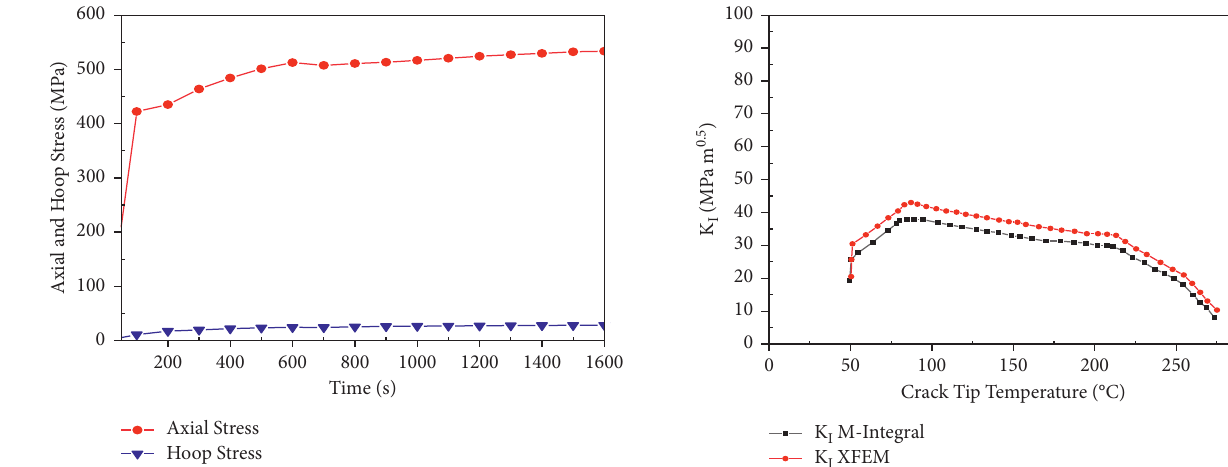
Figure 18: Comparison between M-integral and XFEM K estimations.